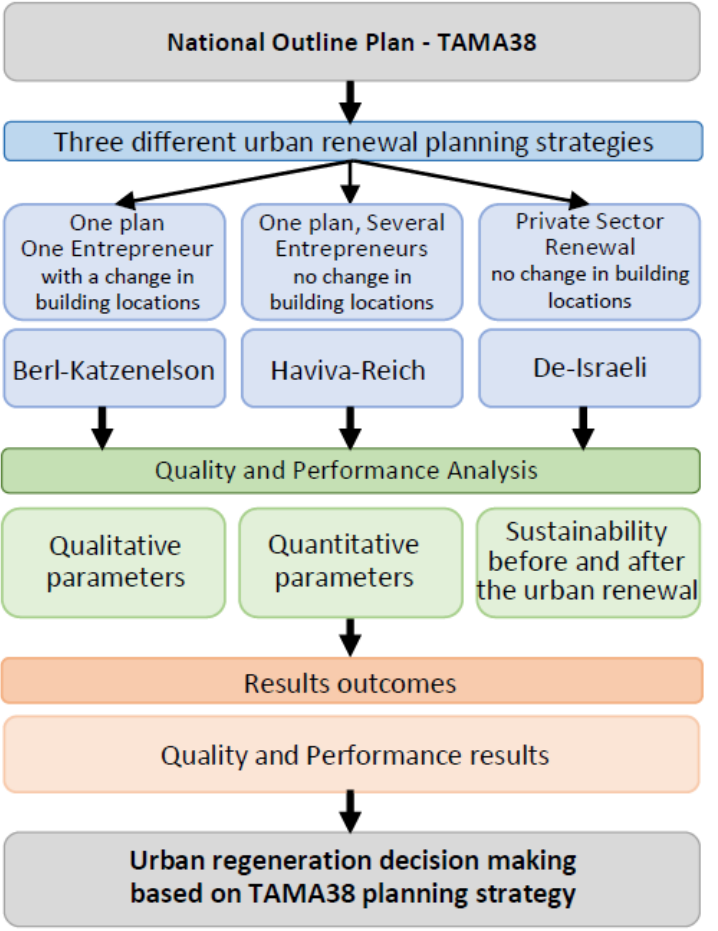
Figure 1. The study’s flow.